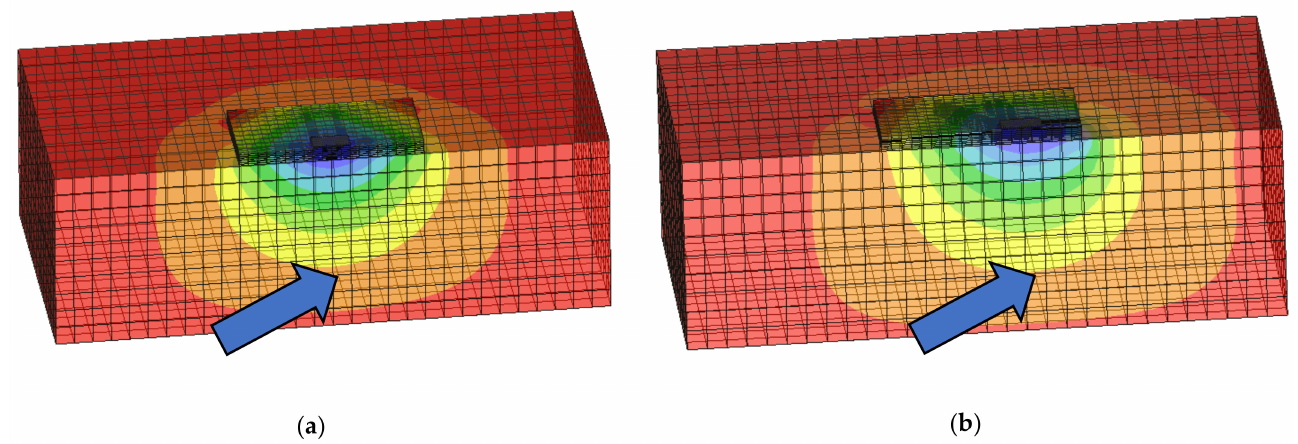
Figure 2. Deformations for slab: ( a ) centrically loaded slab; ( b ) eccentrically loaded slab.